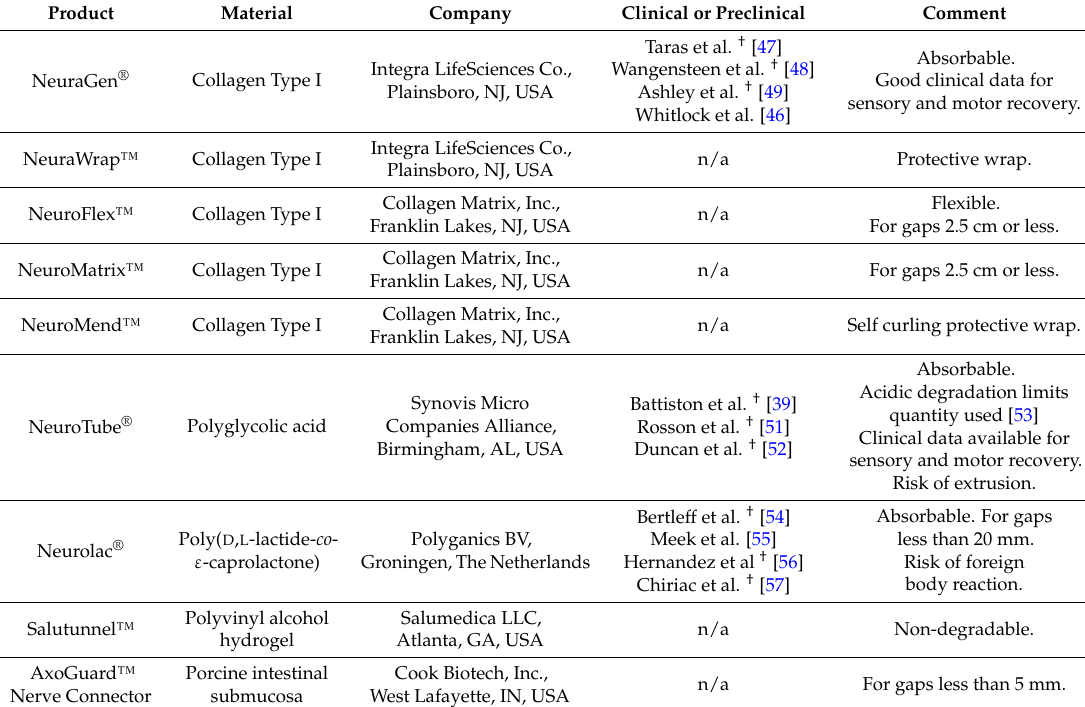
Table 1. Food and drug administration (FDA) approved nerve graft